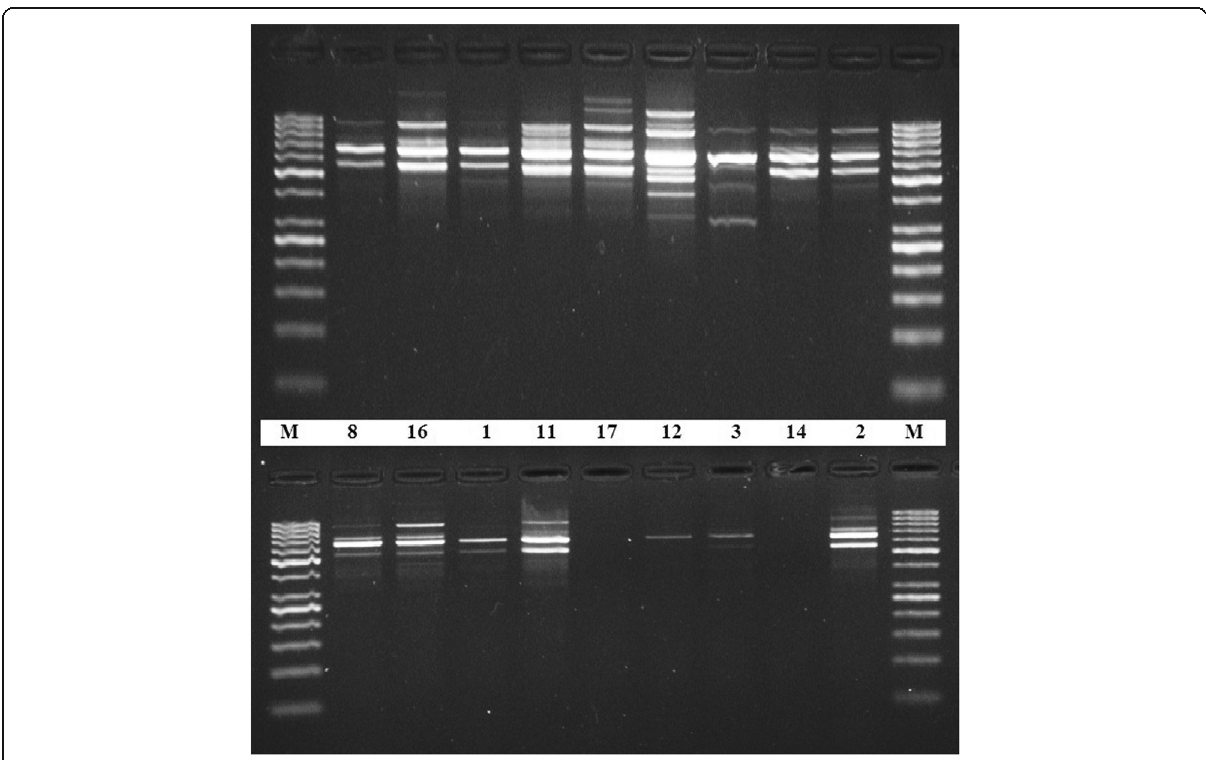
Fig. 4 PCR amplification with RAPD primer (OPZ-09). PCR amplification of OPZ-09 primer and electrophoresis separation by 1.5% agarose gel of some DNA samples extracted by the standardized method (upper lane) and the classical method (lower lane). M is for molecular marker (50